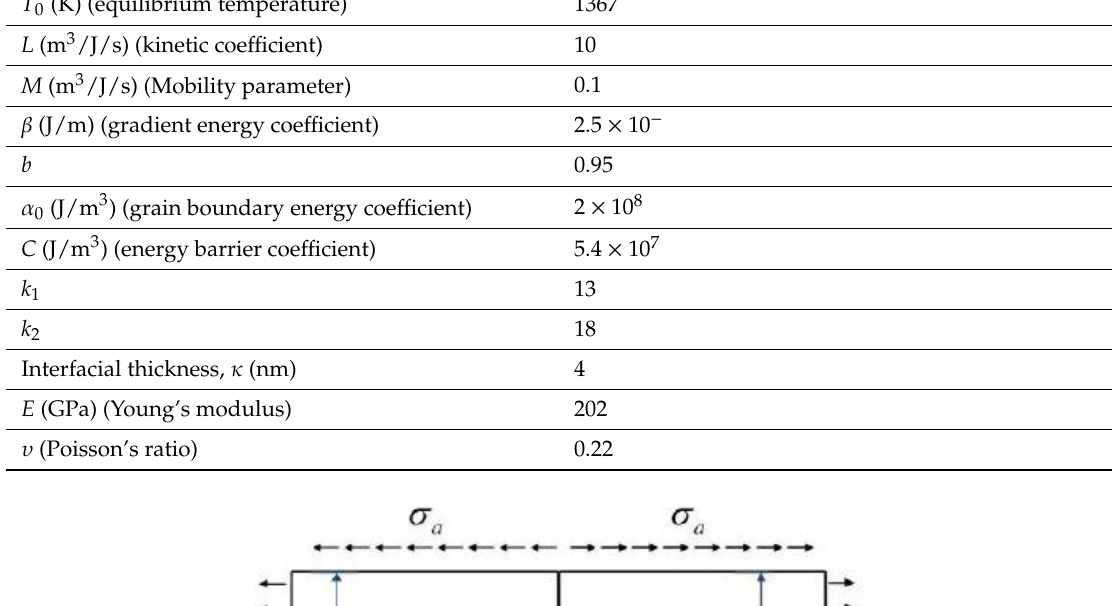
Table 2. Material properties and the other parameters in the phase field (PF) simulation.